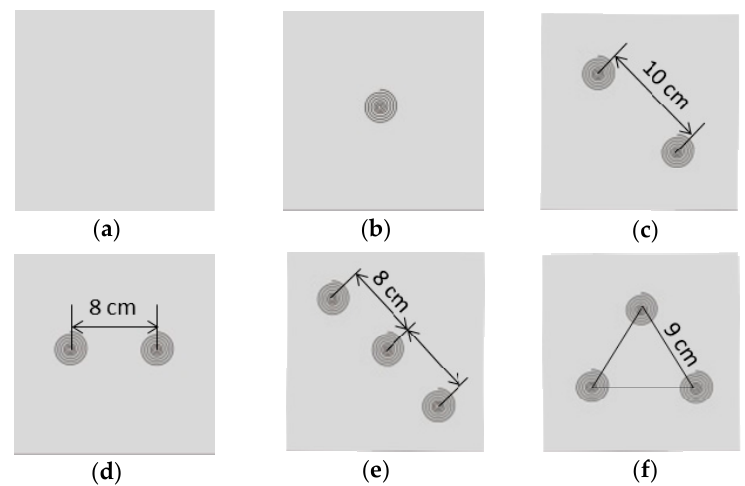
Figure 2. Six different arrangement modes of SMA spring: ( a ) CON: control group without any spring; ( b ) One: one spring at the center; ( c ) Two Diag: two springs positioned diagonally; ( d ) Two Para: two springs positioned in parallel; ( e ) Three Diag: three springs positioned diagonally; ( f ) Three Tria: three springs arranged at the vertices of an equilateral triangle.